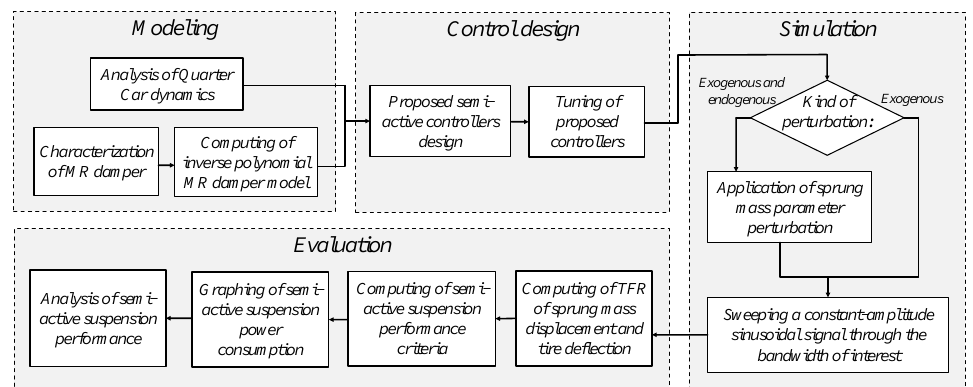
Figure 1. Proposed research